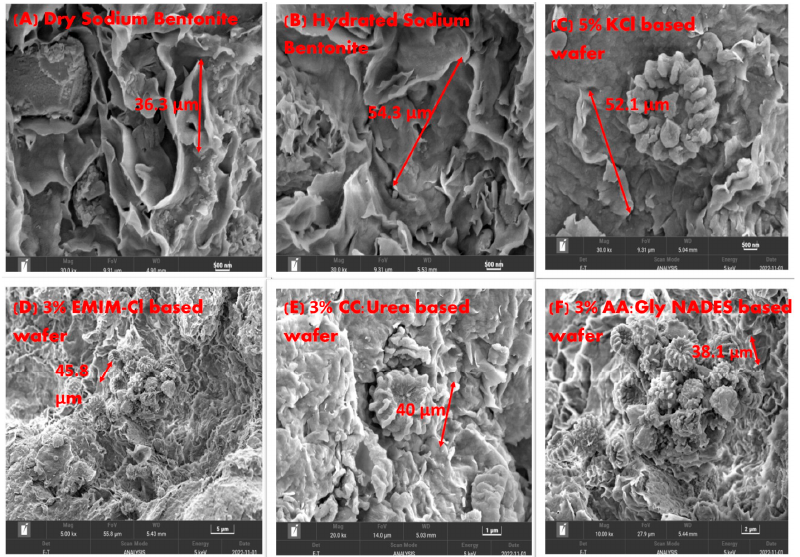
Figure 12. FESEM of: ( A ) dry bentonite at 500nm resolution, ( B ) hydrated sodium bentonite at 500nm, ( C ) 5% KCl based sodium bentonite wafer at 500 nm, ( D ) 3% EMIMCl based wafer at 5µm, ( E ) 3% CC:Urea based wafer at 1 µm, ( F ) 3% AA:Gly based wafer at 1µm.